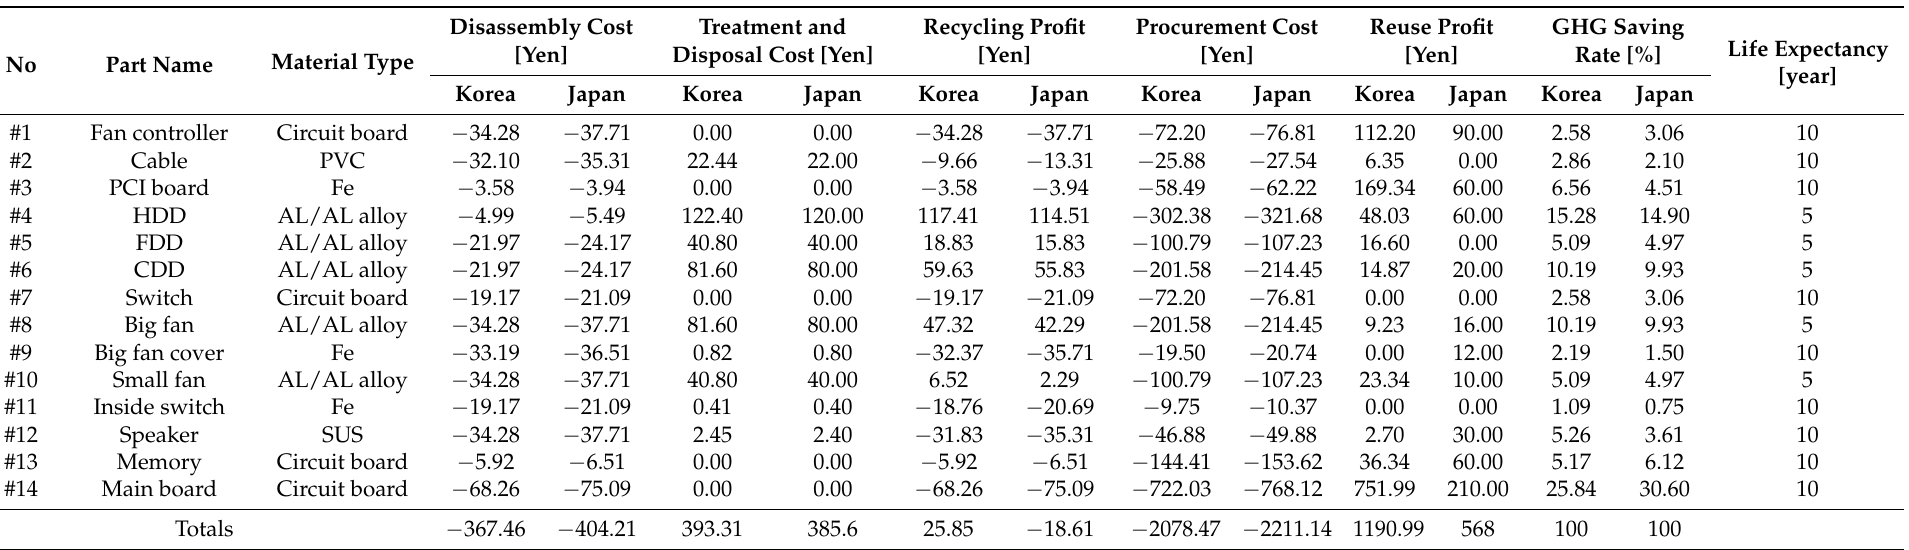
Table A1. All estimated data of each component on a five usage-years